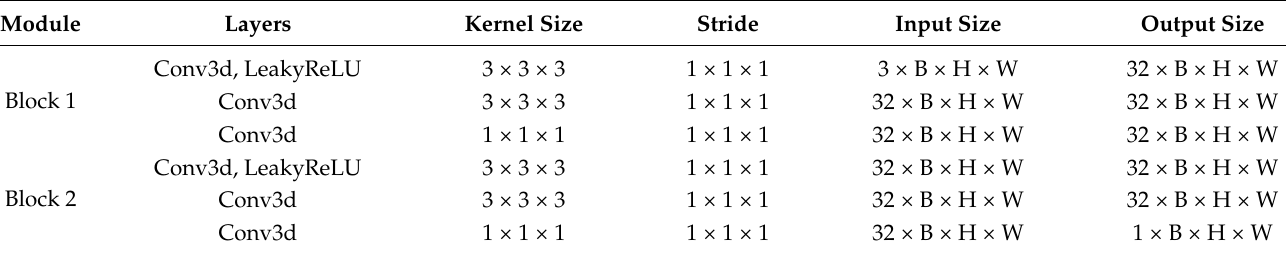
Table 2. Network configuration of the degenerator.